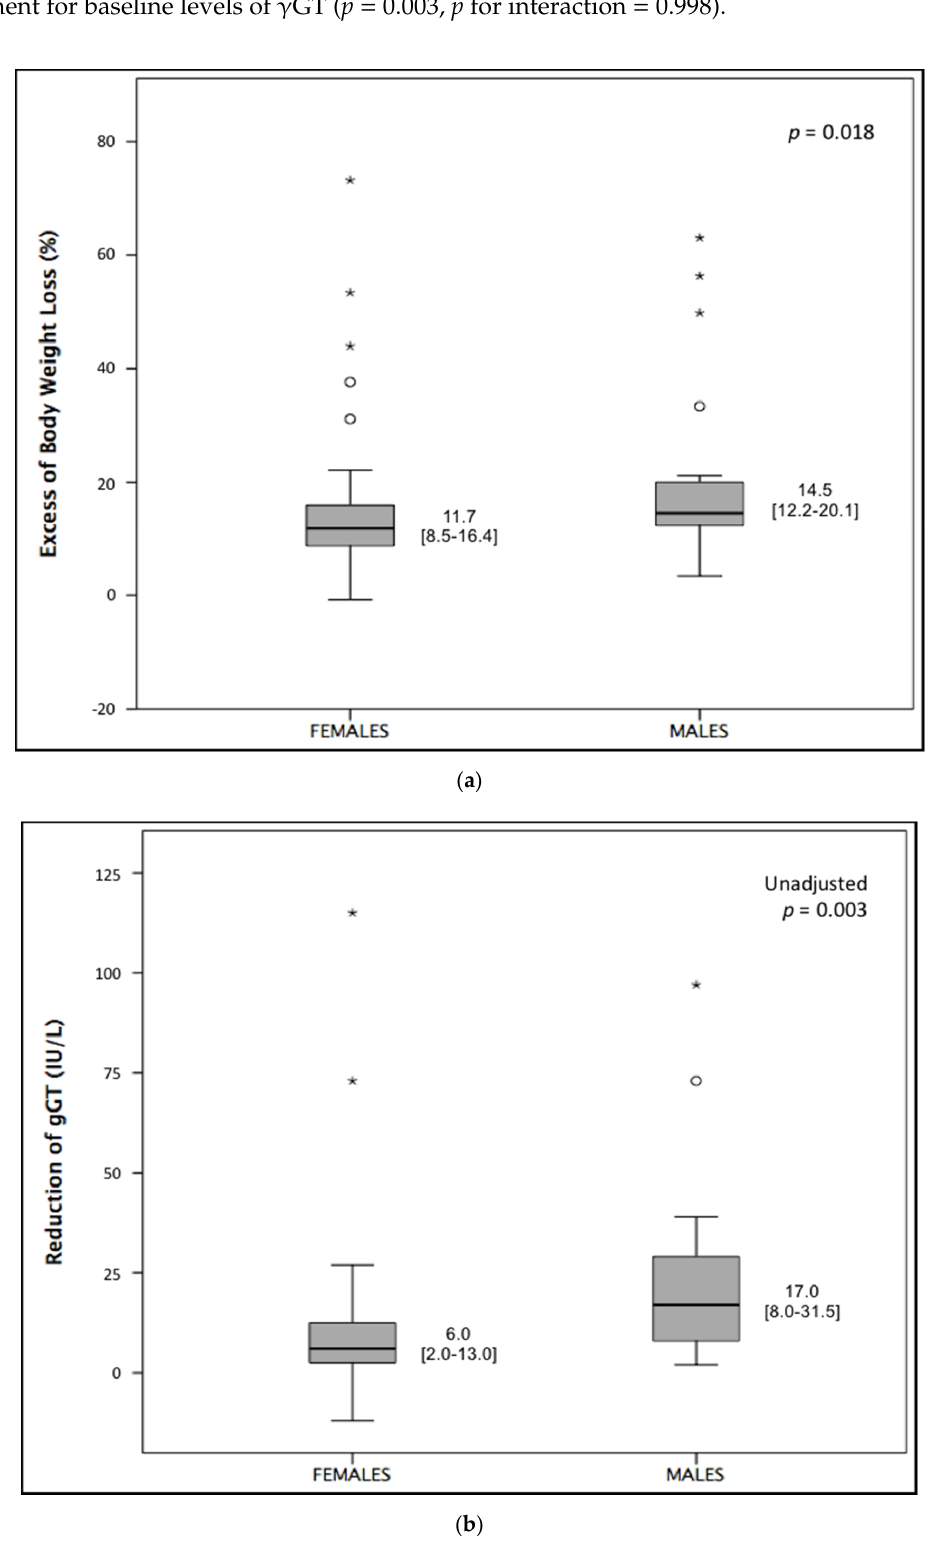
Figure 2. Comparison of ( a ) excess of body weight loss (EBWL) and ( b ) reduction in gamma-glutamyl transferase (gGT) between males and females (Kruskal–Wallis test). * and depict outliers.